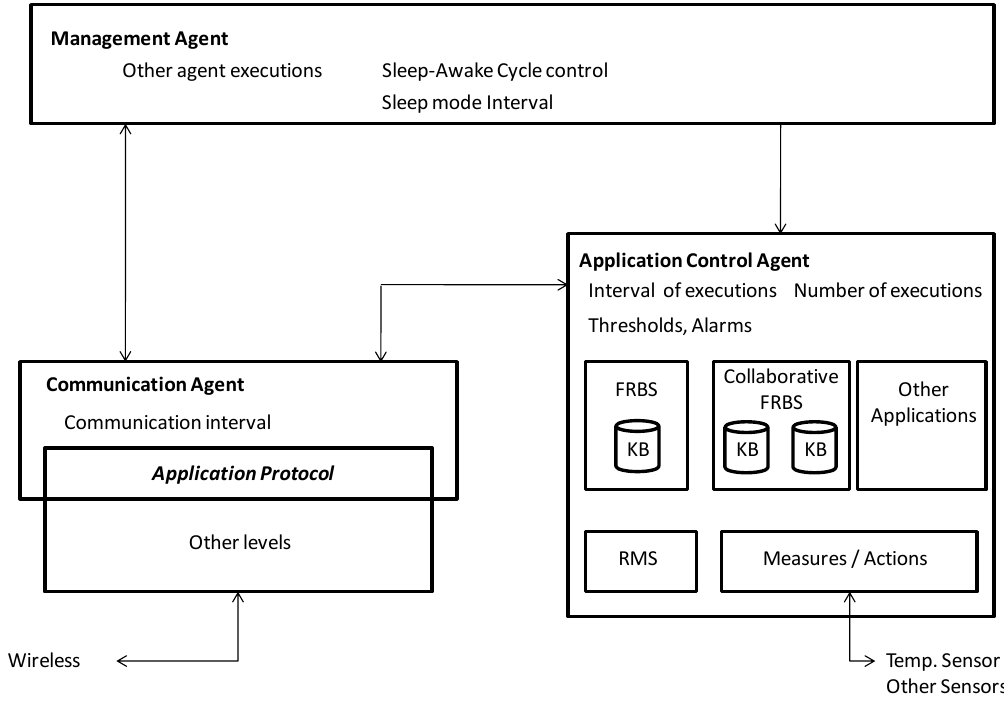
Figure 1. Multi-agent software structure in